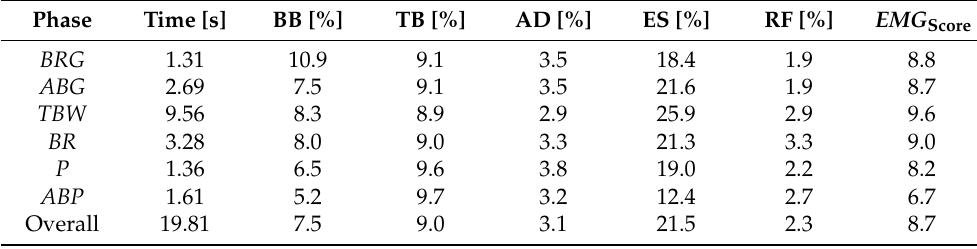
Figure 4. Vertical acceleration of the CoM as function of the time. In red circles, the notable points correspond to the different events. Notice that, different to definitions in the section, we have used the following nomenclature: 1 = BRG ; 2 = ABG ; 3 = TBW ; 4 = BR ; 5 = P ; 6 = ABP . Table 1. Root mean square of the normalized muscle activation values for the five muscles ( BB : biceps brachii, TB : long head of the triceps brachii; AD : anterior deltoid, ES : erector spinae at L3 level, RF : rectus femoris) under investigation for each phase ( BRG : bend and reach plus grasp; ABG : arise from bend, get; TBW : turn body and walk; BR : bend and reach; P : positioning; ABP : arise from bend, put) of the task with relative time duration ( Time ) and EMG Score